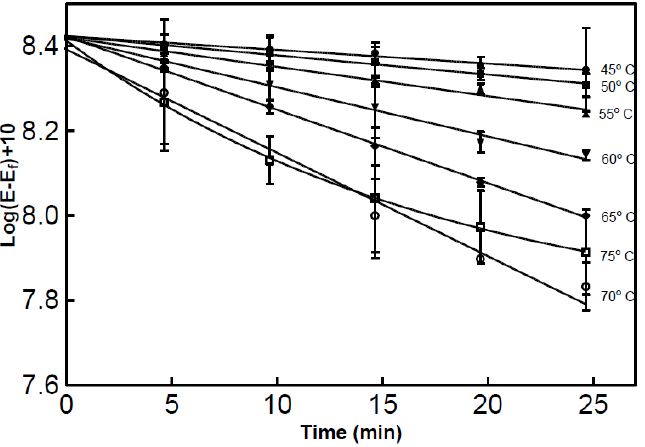
Figure 5. Effect of temperature on partially purified RNase activity. Measurements were in triplicate using a modified version of the real-time assay developed by Kunitz